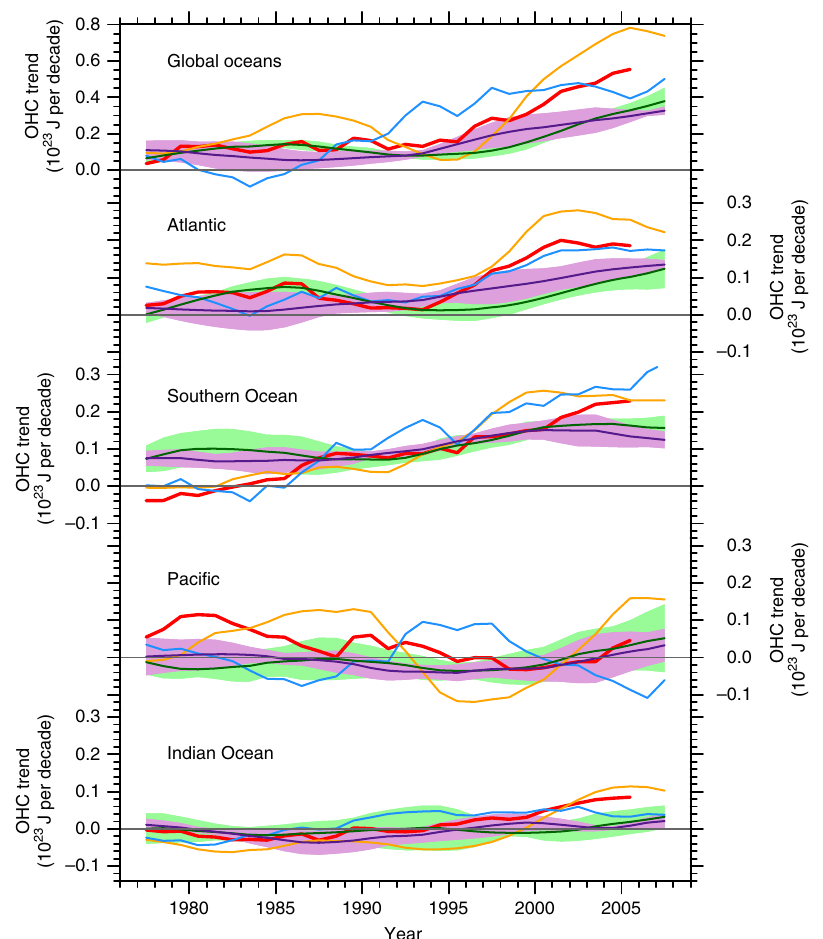
Figure 2 | 300–1,500m ocean heat content trends. The 15-year running mean 300–1,500m ocean heat content (OHC) trends in the global oceans, Atlantic, Southern Ocean, Pacific and Indian Ocean from observations: the Ishii (red), EN4 (orange) and ECMWF ORAS4 data (blue), and the CESM simulations: the Hiatus/Surge group (dark green/purple curve for the ensemble mean and light green/plum shading for ± 1 s.d. range across ensemble members). Annual mean time series are used in the computation. The year represents the centre of the time period used to calculate the